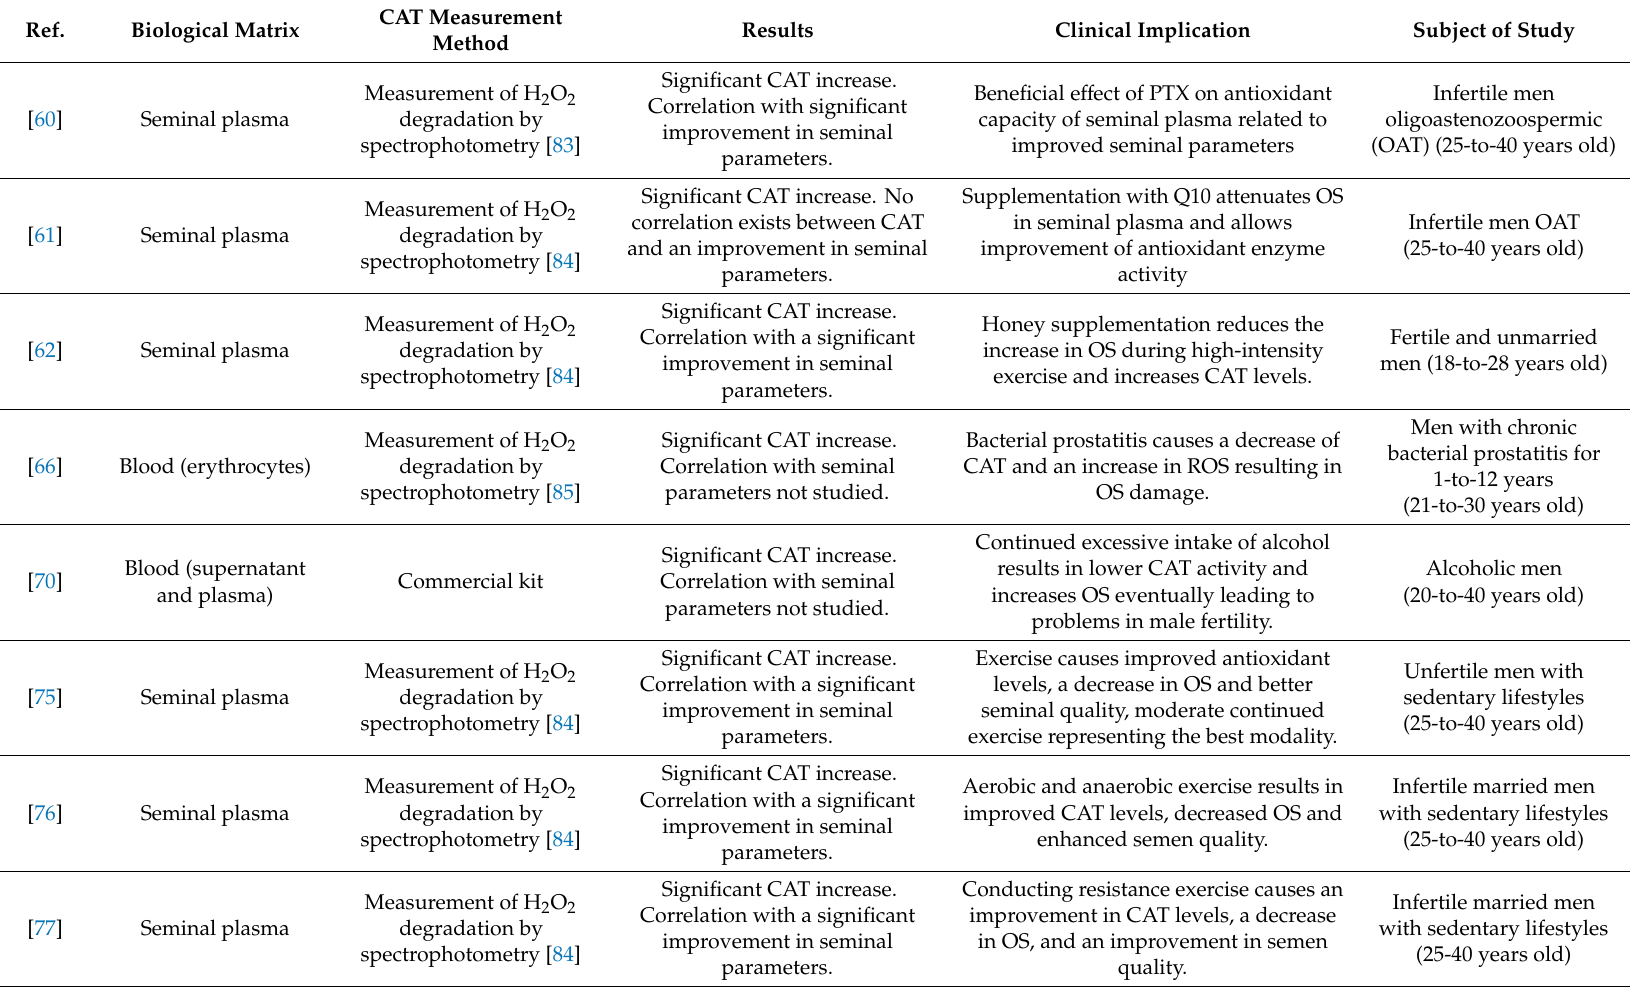
Table 5. Summary of the clinical trials